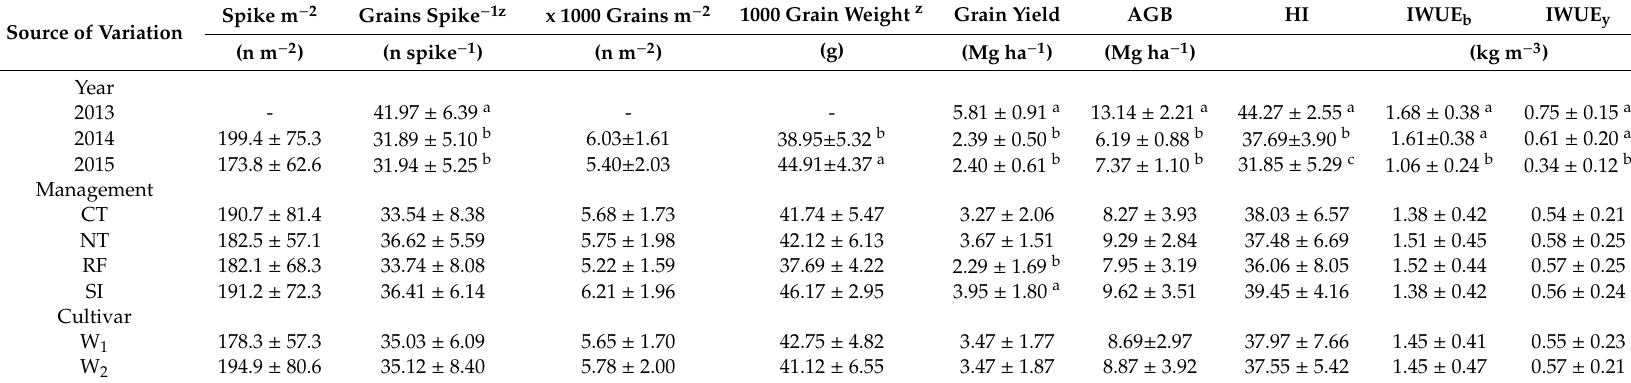
Table 7. Yield and yield components and irrigation water use e ffi ciencies as a ff ected by year, agronomic management, water regime and cultivar under barley experiment. Source of